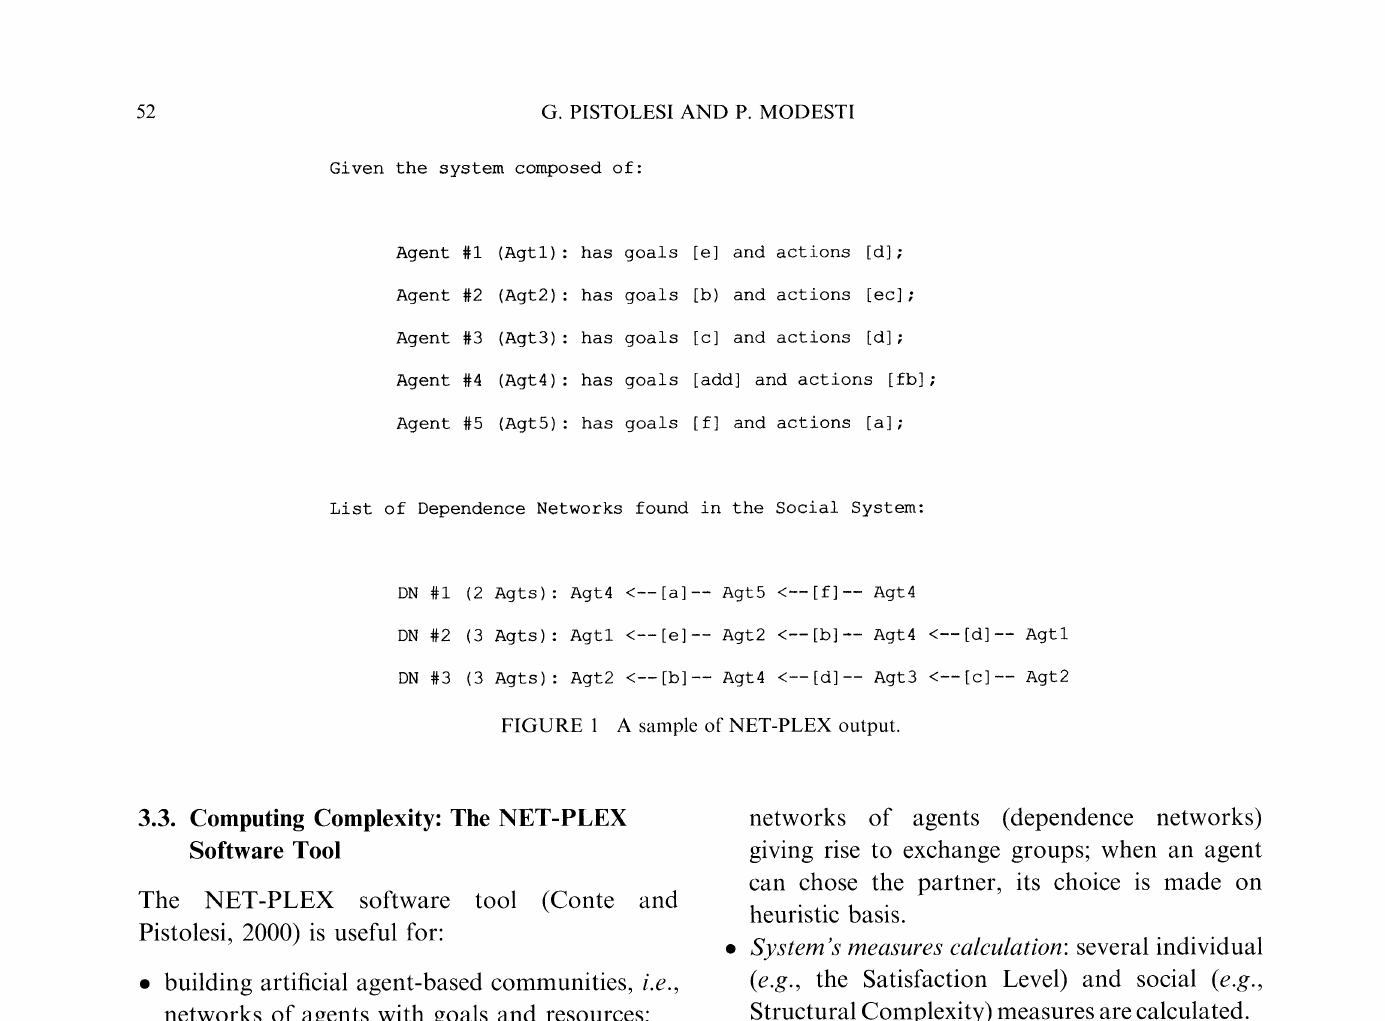
FIGURE A sample of NET-PLEX output.